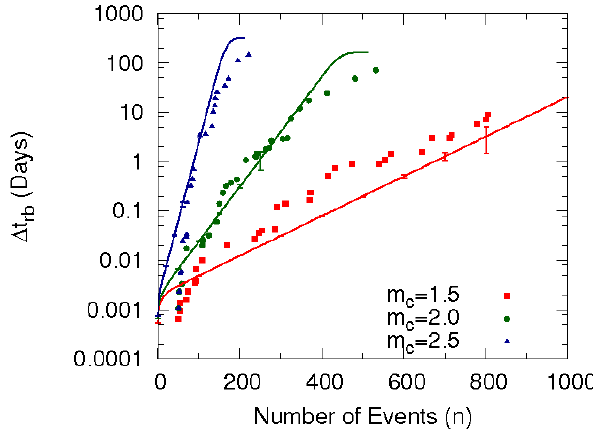
Fig. 4. Numbers of record-breaking longest intervals, n rb , are given as a function of event number n (natural time). Results are given for the Parkfield aftershock sequence, starting 0.01days after the main-shock, compared to a simulated non-homogeneous Poisson process (NHPP). The blue, green and red points represent data from the Parkfield aftershock sequence for m c = 1 . 5 , 2 . 0 , 2 . 5, respectively. The solid lines and error bars of the same colour represent the mean and standard deviation, over 1000 simulations, from the cor- responding NHPP.